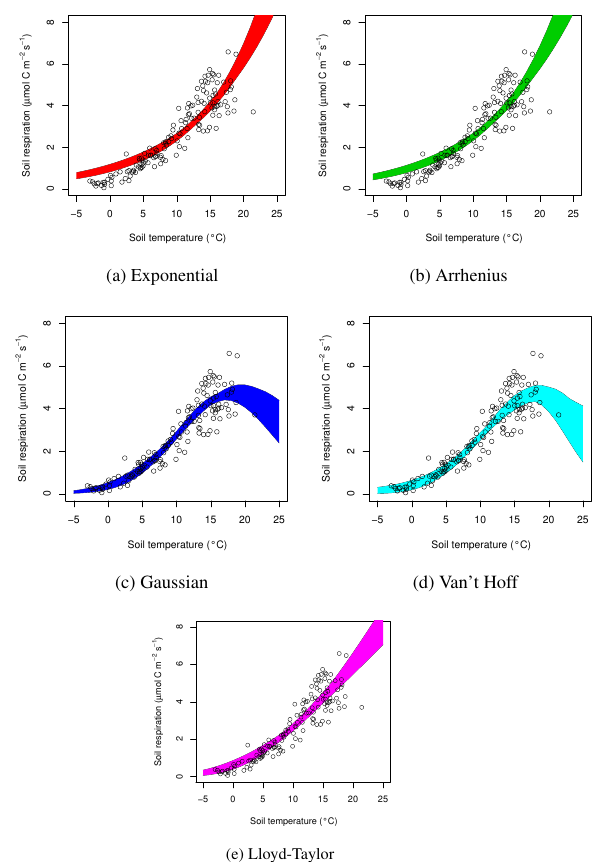
Fig. 2. Uncertainty bound for each candidate temperature response Fig. 2: Uncertainty bound for each candidate temperature response formulation spanned out by the sampled function parameter range sets for the site HOW. The abbreviation of the site is explained in Tab. 2. function spanned out by the sampled function parameter range sets for the site HOW. The abbreviation of the site is explained in Ta- ble Fig. 2: Uncertainty bound for each candidate temperature response formulation spanned out by the sampled function parameter range sets for the site HOW. The abbreviation of the site is explained in Tab. 2. Fig. 2: Uncertainty bound for each candidate temperature response formulation spanned out by the sampled function parameter range sets for the site HOW. The abbreviation of the site is explained in Tab. 2.